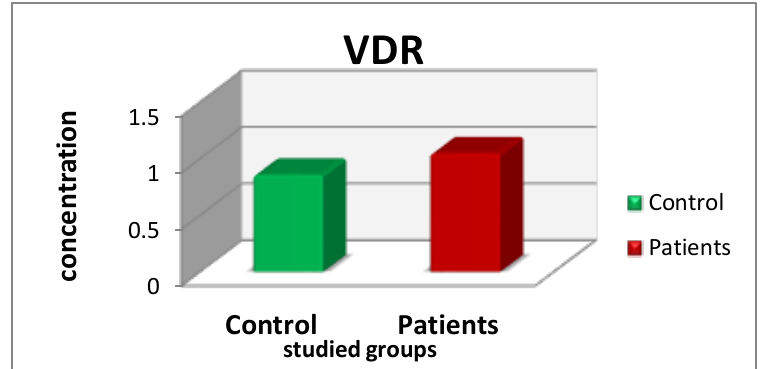
Figure 5: Levels of Vitamin D receptor in patients and control groups.